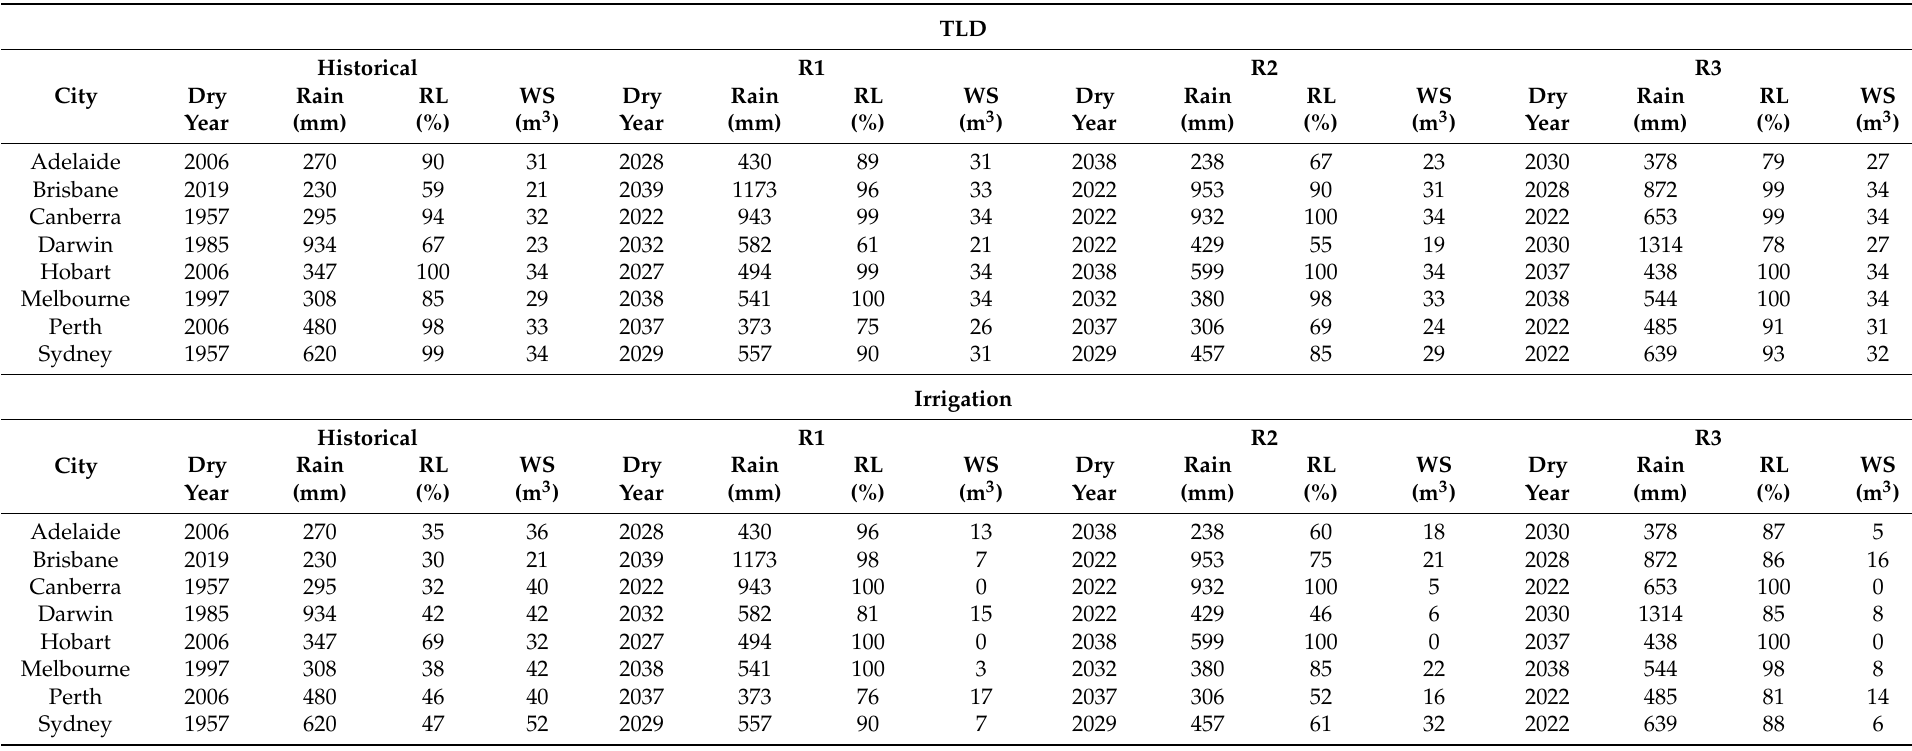
Table 2. Summary of dry year rainfall, reliability and water savings for all the eight cities for both the historical and future period (TLD and irrigation use).